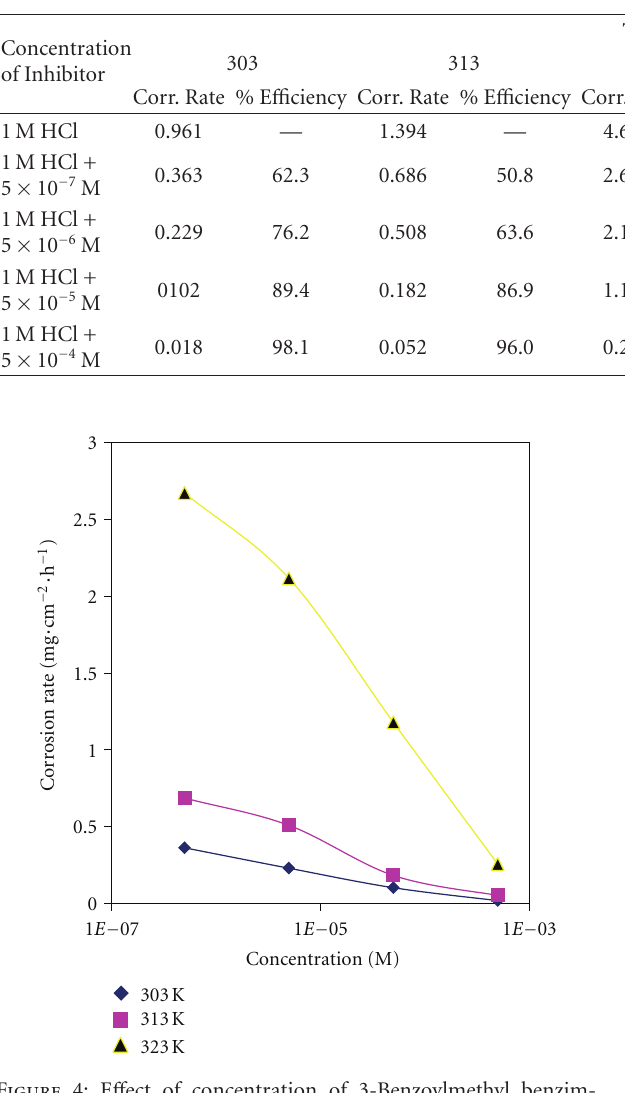
Figure 4: E ff ect of concentration of 3-Benzoylmethyl benzim- idazolium hexafluoroantimonate (BMBI) on the corrosion rate (mg · cm − 2 · h − 1 ) of mild steel in 1.0 M HCl at various temperatures.